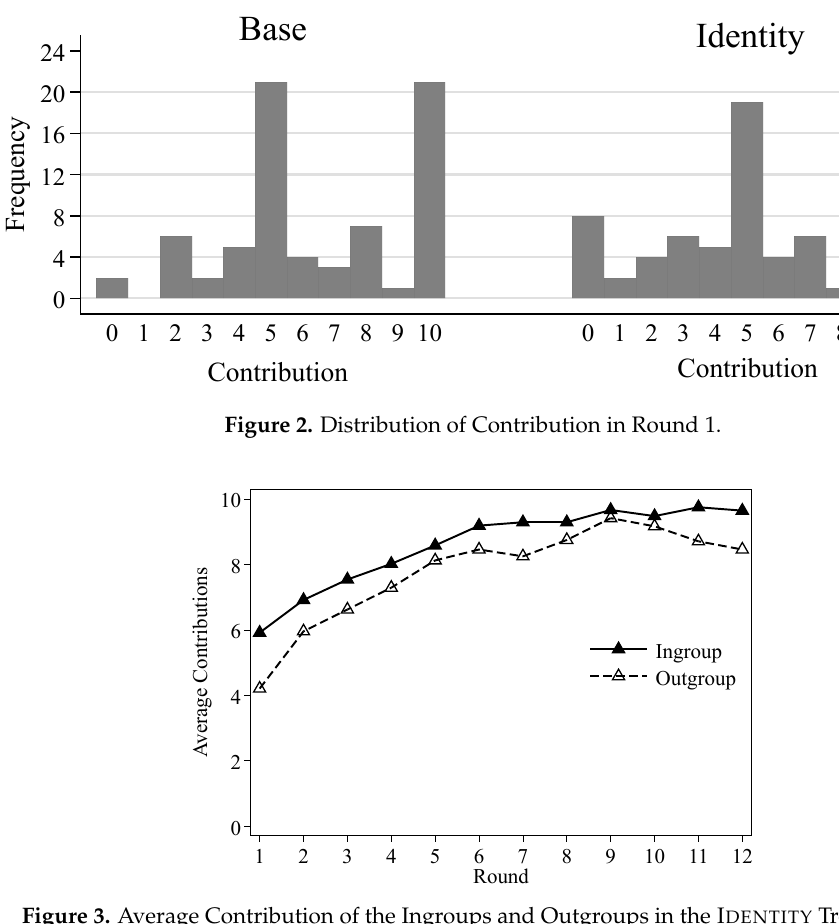
Figure 3. Average Contribution of the Ingroups and Outgroups in the I DENTITY